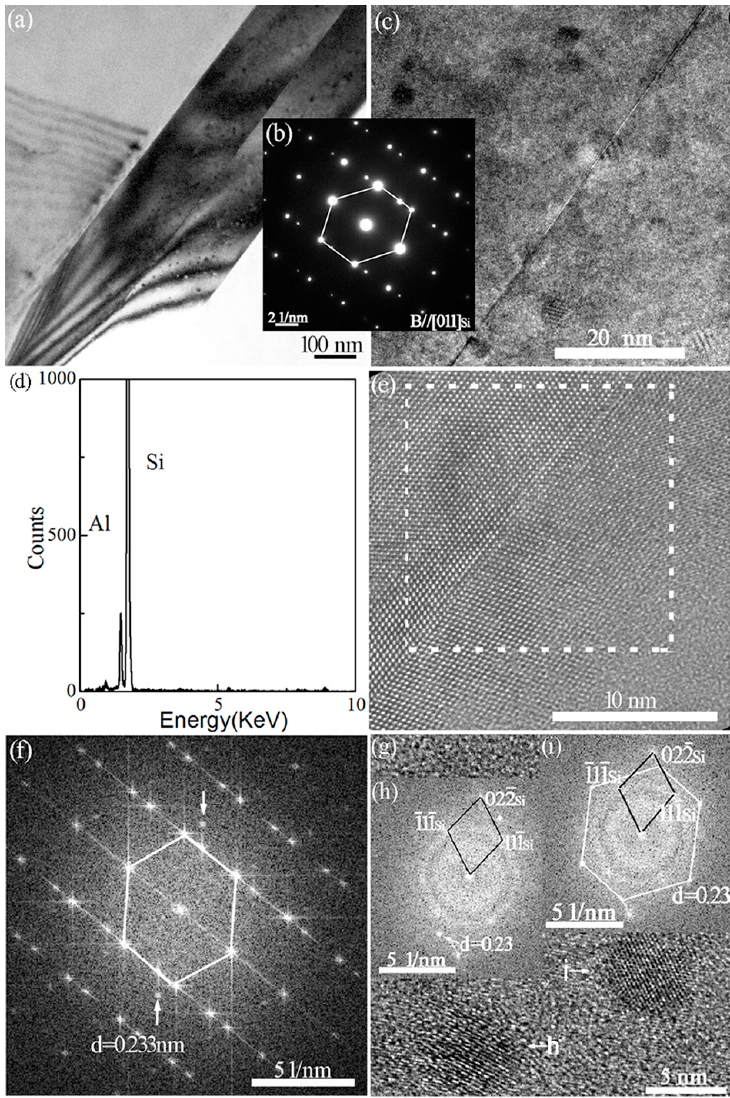
Figure 4. Microstructure within eutectic Si of Al–10Si–0.35Sb alloys. ( a ) TEM dark–field image, ( b ) SAED patterns, ( c ) high number density nanoparticles, ( d ) EDS spectrum, ( e ) HRTEM image of particle penetrated by twin boundary, ( f ) FFT of lattice image marked with dotted box in ( e ), ( g ) HRTEM lattice image of nanoparticles, ( h ) FFT of lattice image denoted as “h” in ( g ), and ( i ) FFT of lattice image denoted as “i” in ( g ).